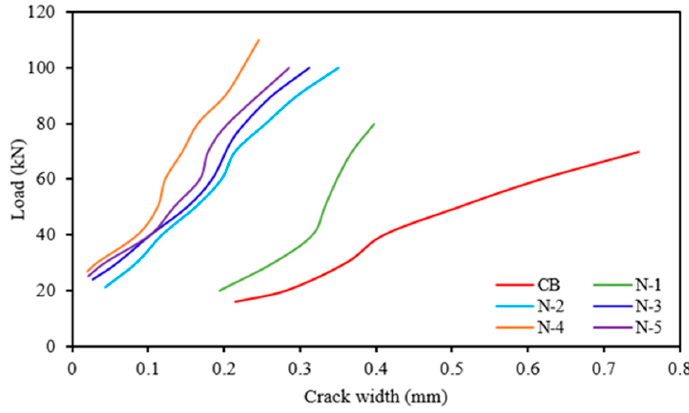
Figure 4. Load vs. crack width for all beams.